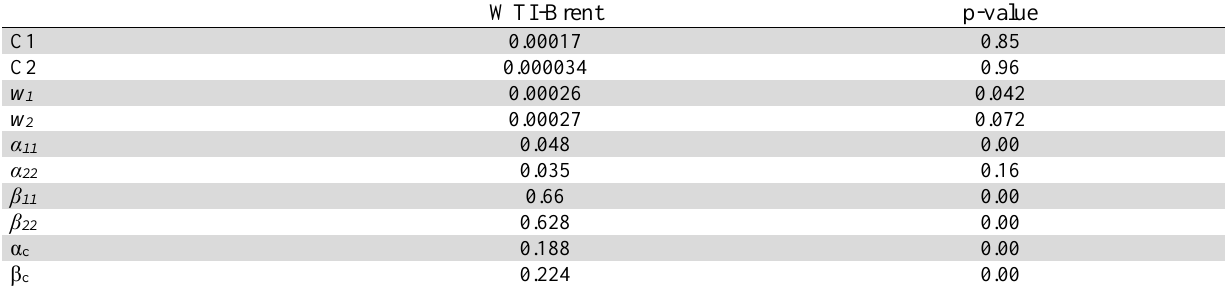
Results of the GARCH-DCC (1,1) Bivariate 5 models